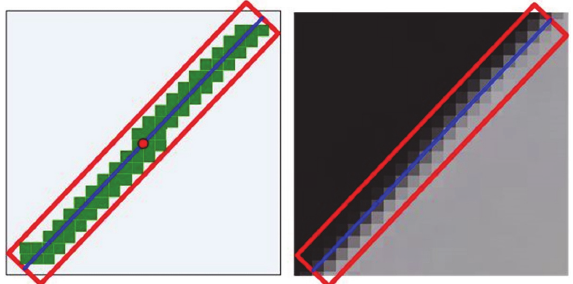
Figure 8: Schematic diagram of the line segment